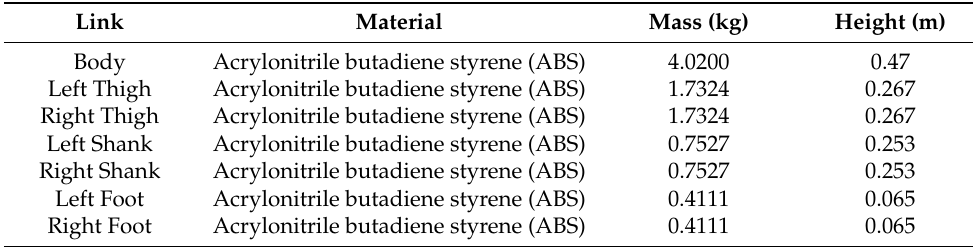
Figure 6. Shape and size of the bipedal robot’s links. Table 1. Mass, height and material of links of robot.